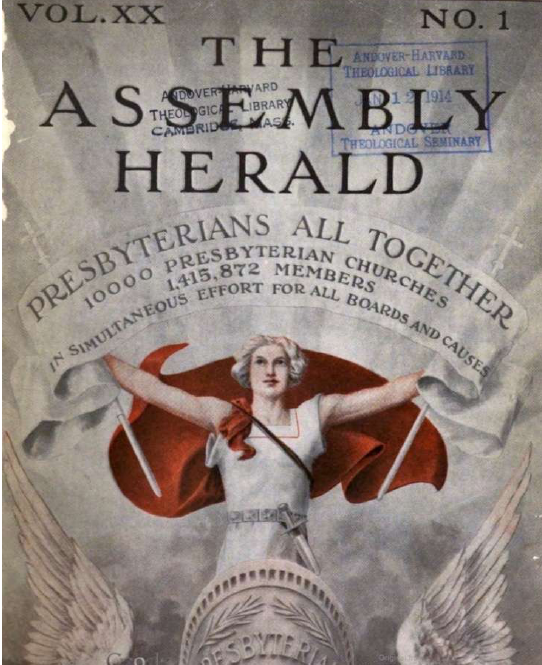
Figure 2. Assembly Herald January 1914 cover. The main publication of the Presbyterian benevolent boards opened 1914 with an image of the church militant. Following the outbreak of World War I months later, the use of military imagery and rhetoric would help the Board of Foreign Missions close its debt and raise additional capital. Source: Assembly Herald 10, no. 1 (January 1914):